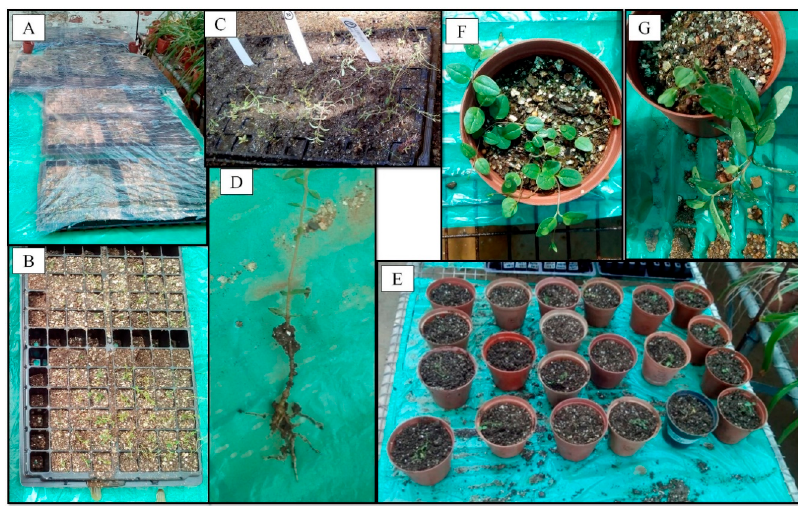
Figure A3. Ex vitro rooting and acclimatization of all three Brachystelma species. ( A ) Humidity cover retaining moisture during the first week of acclimatization in the greenhouse. ( B ) Brachystelma species in potting trays in the mist house prior to acclimatization in the greenhouse. ( C ) Brachystelma species growing in the greenhouse. ( D ) Ex vitro derived roots on a healthy growing regenerated plant. ( E ) Brachystelma species, transferred from trays to pots, growing in the greenhouse. ( F ) Fully acclimatized Brachystelma ngomense . ( G ) Fully acclimatized Brachystelma pygmaeum .